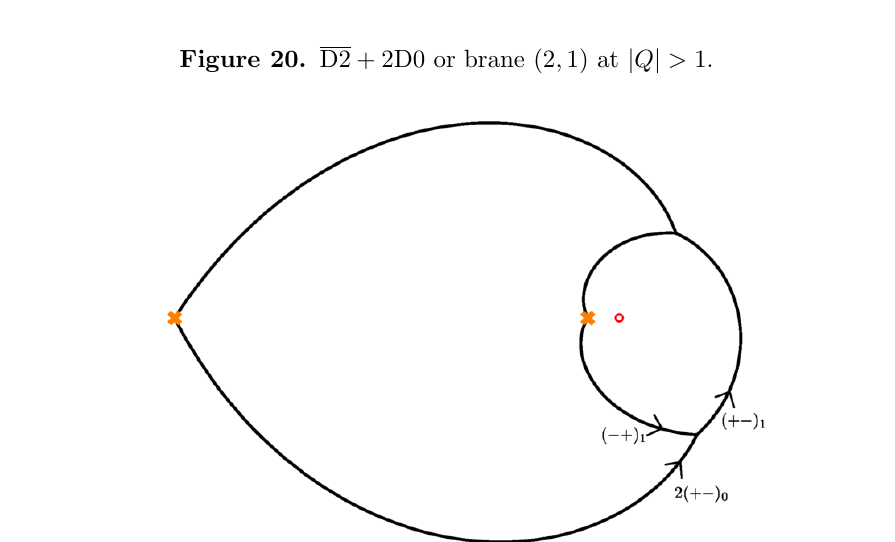
Figure 20. D2 + 2D0 or brane (2 ; 1) at j Q j > 1.